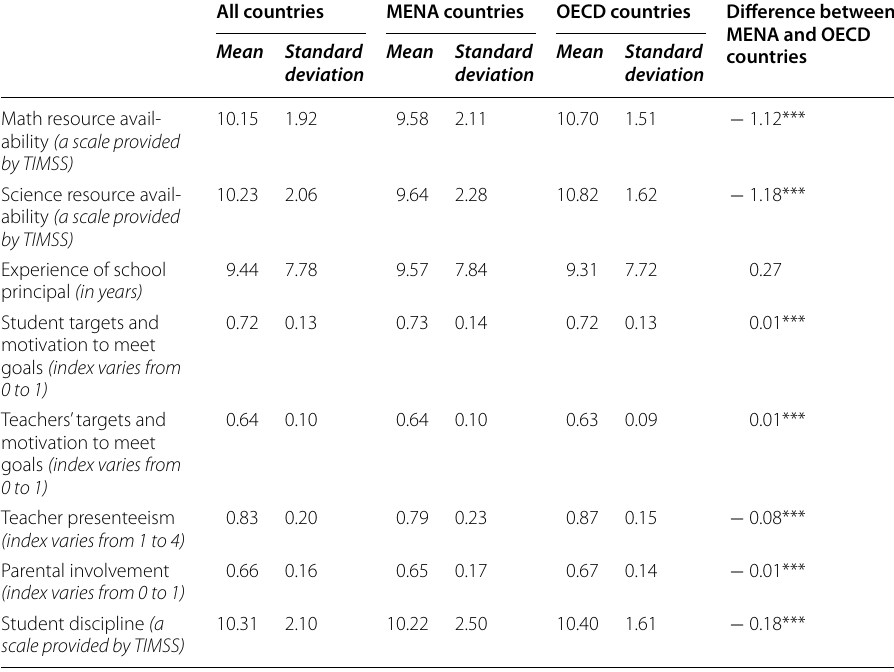
Table 4 Second stage summary